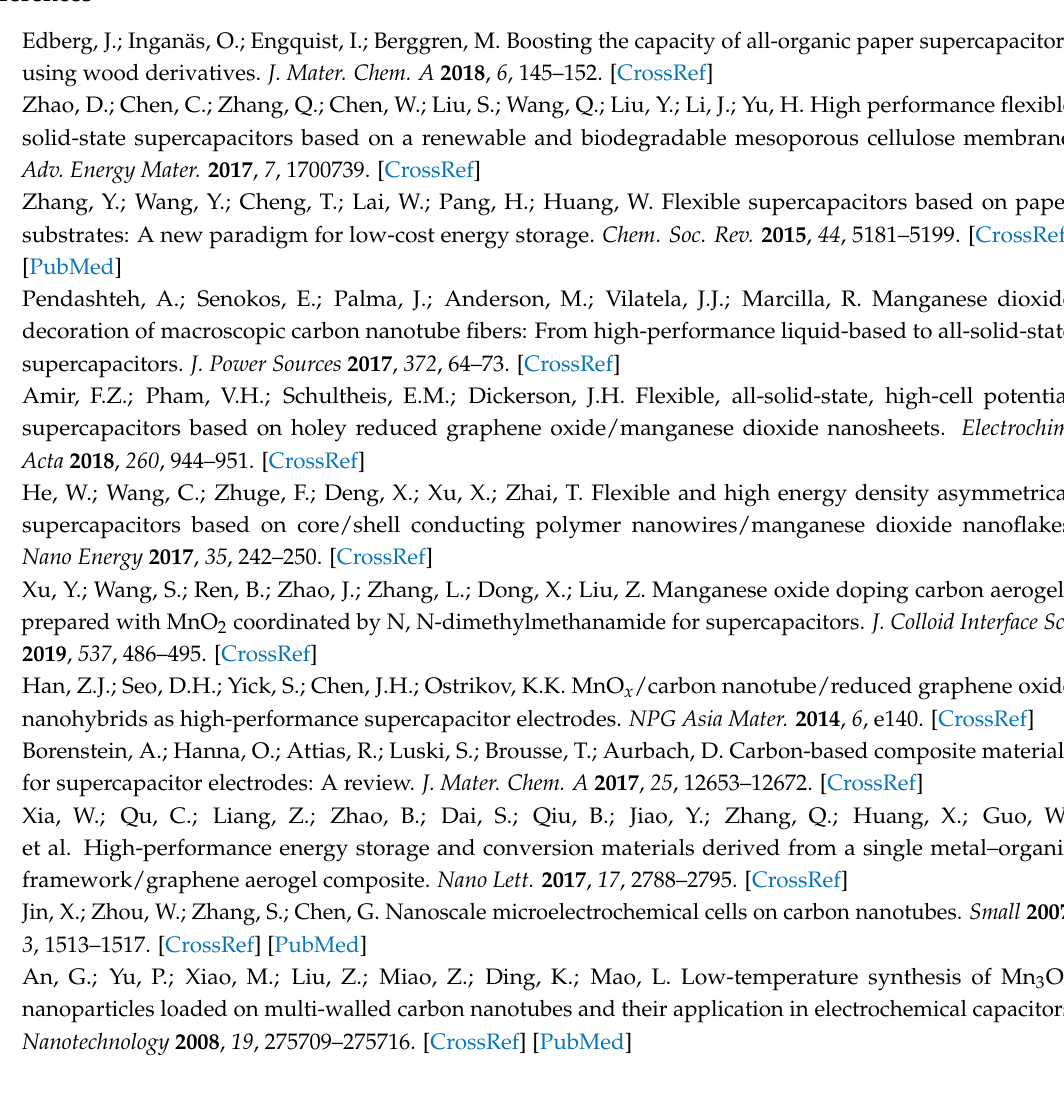
Figure S1: TGA curves of CNF/MnO x composite aerogels, Figure S2: CV curves of the CNF/MnO x electrodes at scan rate of (a) 5 mV s − 1 and (b) 50 mV s − 1